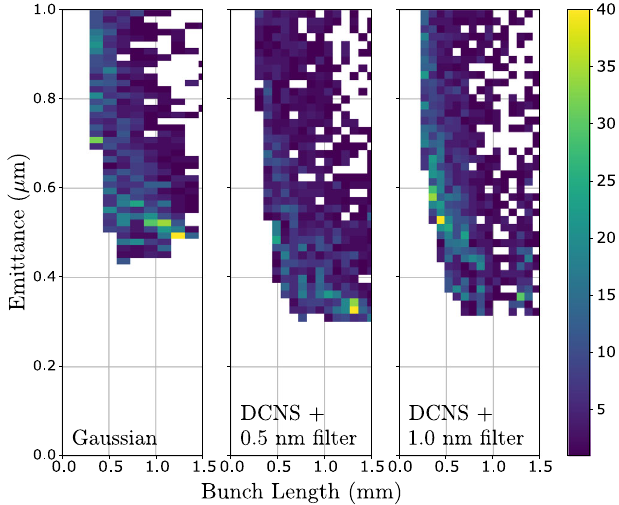
5. Histogram showing simulation density of all GA solutions, not only Pareto optimal, for Gaussian and DCNS cases. Lighter colored areas indicate a higher number of simu- lations with valid solutions and thus regions where different methods might be more